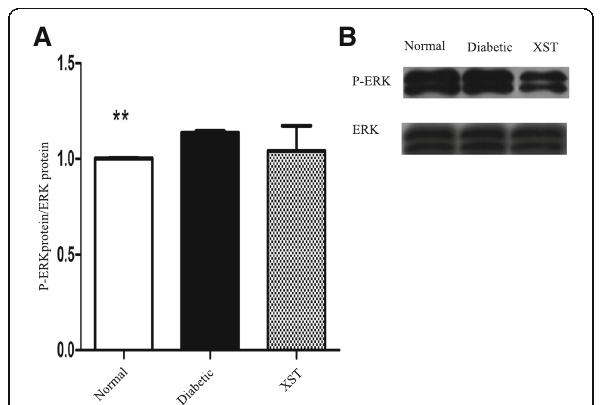
Fig. 6 The effect of XST on protein levels P-ERK and ERK. a The ratio of P-ERK/ERK was compared. b The images of WB results. XST decreased the ratio of P-ERK/ERK. Data were represented as mean ± S.D. ( n = 3 – 4). **: P < 0.01, compared to Diabetic